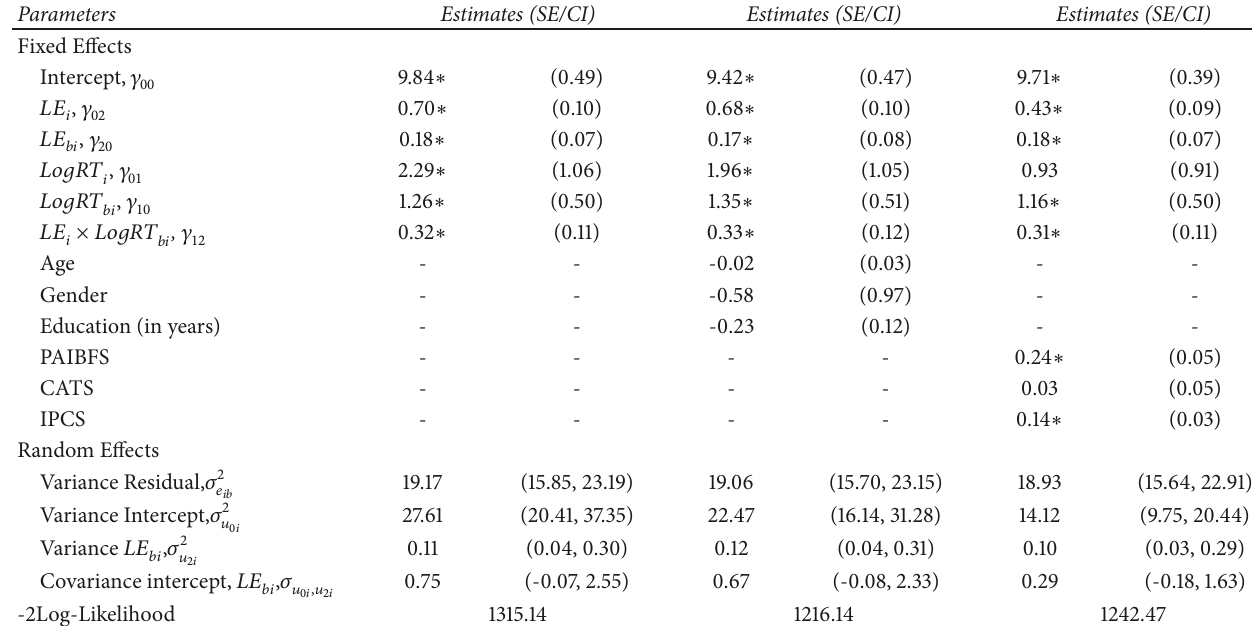
Table 1: Results from the final model examining association between depressive symptoms and log recovery time of sadness, after controlling for life events in each model.